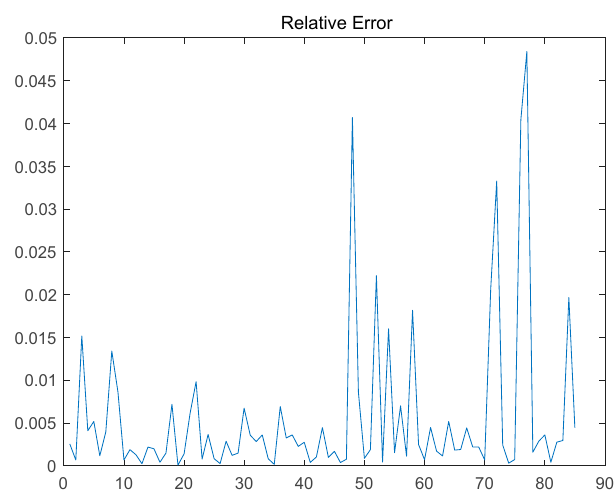
Figure A1. Comparison of output value with expected value in Hongxia community.